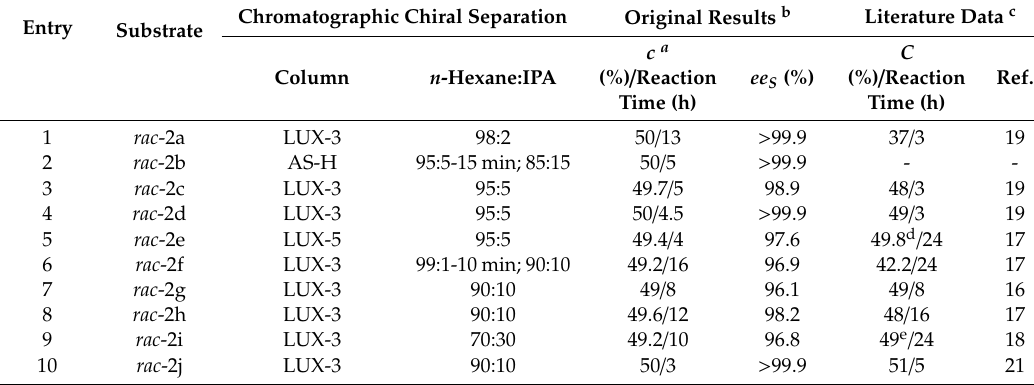
Table 3. EKR of various heteroarylethanols rac - 2a – j .